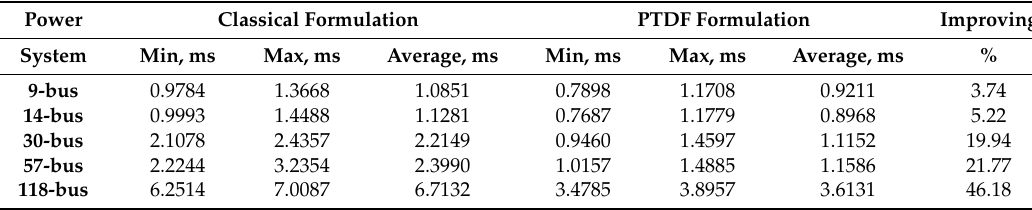
Table 3. Simulation time using both formulations applied to different power